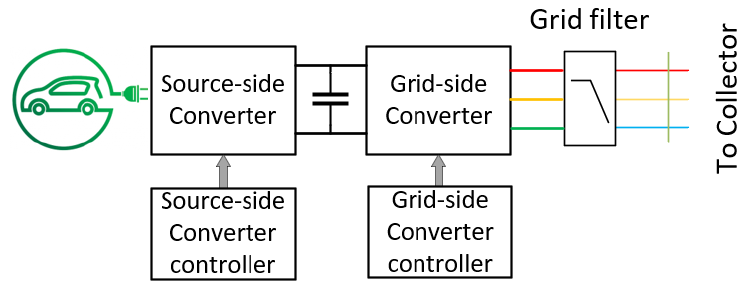
Figure 1. Schematic diagram of an EVGI system.